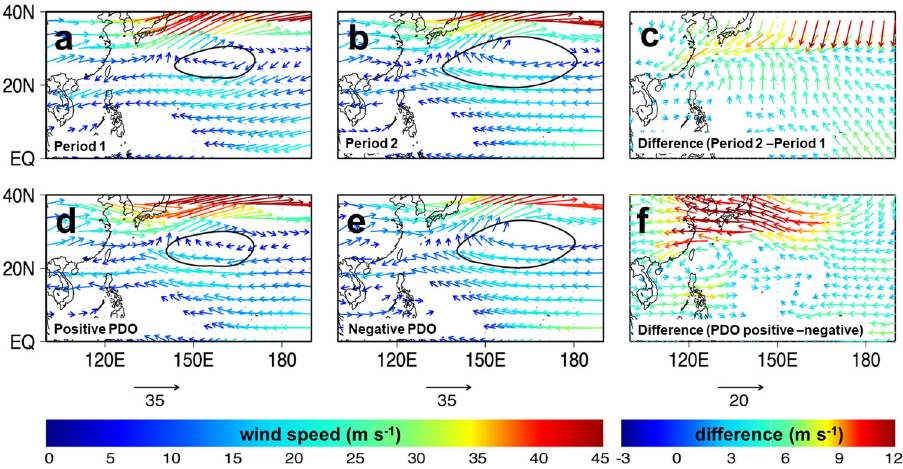
Fig. 5 Integrated environmental steering fl ow from 850 to 500 hPa in the Western North Paci fi c (WNP) during the mature boreal autumn. a − c Mean 850 − 500 hPa steering fl ow during the Period 1 (1981 − 1997) and Period 2 (1998 − 2019), and their difference, respectively. d − f Mean 850-500 hPa steering fl ow during the positive and negative PDO phases, and their difference, respectively. In a , b and d , e , the black contour indicates the position of the WNP subtropical high ( = 5875 gpm) during the indicated period.